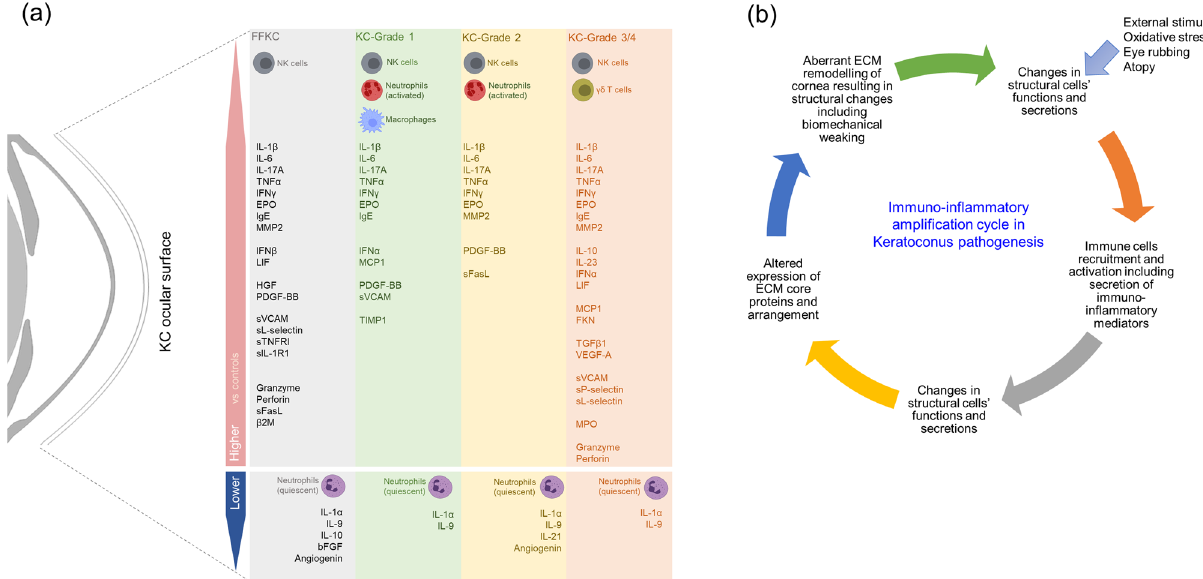
Figure 9. Ocular surface immuno-inflammatory status in KC: ( a ) The schematic represents the immune cell subtypes on the ocular surface of KC patients (across different grades of the disease) that were significantly different increased or decreased compared to controls. The schematic also indicates the various tear fluid soluble factors whose levels were significantly altered in KC (across different grades of the disease) compared to controls. ( b ) Represents the hypothetical immuno-inflammatory amplification cycle in keratoconus pathogenesis. External stimuli including physical and/or biological stimuli, oxidative stress, eye rubbing, etc., can stimulate the corneal structural cells such as the epithelium and keratocytes to secrete various active biologically active factors, including those with inflammatory and chemoattract properties. This will facilitate the recruitment and activation of immune cells on the ocular surface. The activation of immune cells might result in additional secretion of immune- and inflammatory mediators which can adversely impact the homeostasis and function of the corneal structural cells. This can result in aberrant extra-cellular matrix (ECM) remodeling due to decreased collagen synthesis, reduction in endogenous cross-linking enzyme and increased degradation of ECM proteins via proteases. Thus, causing structural and biomechanical changes characteristics of KC. The function of corneal epithelium and keratocytes will further be influenced by changes in the biophysical cues due to altered ECM remodeling, thus contributing to disease progression in